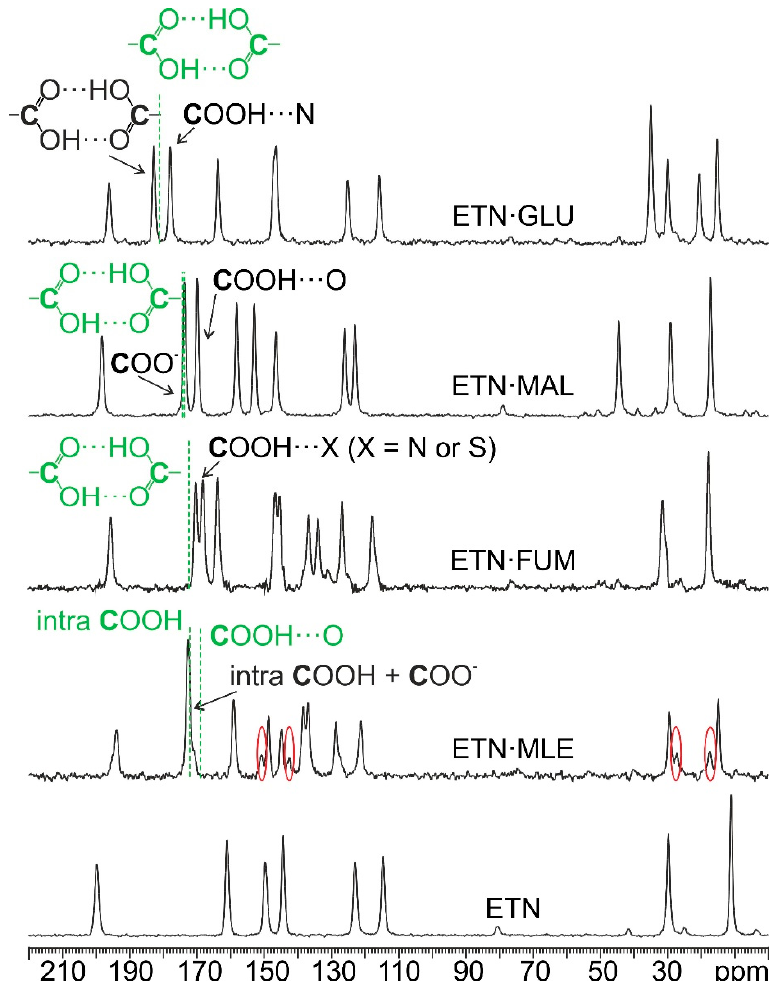
Figure 8. 13 C CPMAS spectra of the analyzed compounds. Dashed green lines and green writings refer to carboxylic signals of the pure acids. Red ovals highlight extra peaks due to crystalline disorder.